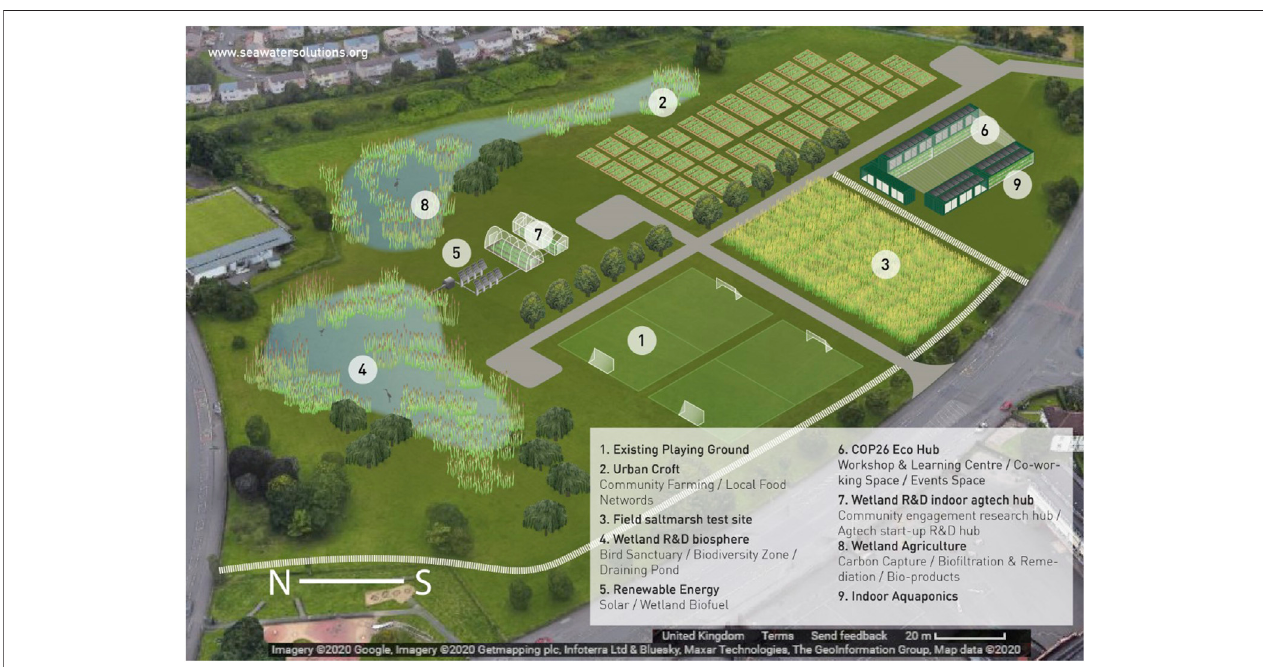
FIGURE 2 | Schematic plan for possible integrated wetland development of Glasgow park proposed by Seawater Solutions.